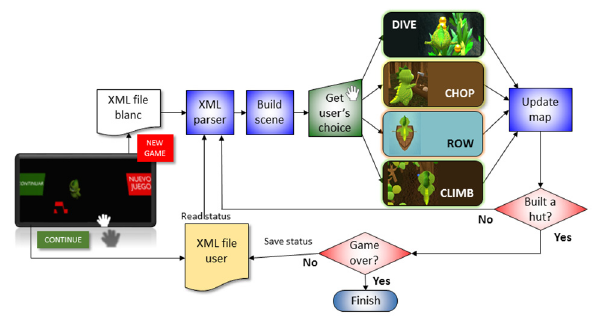
Fig. 4 . Game outline of “Phiby’s Adventures”.